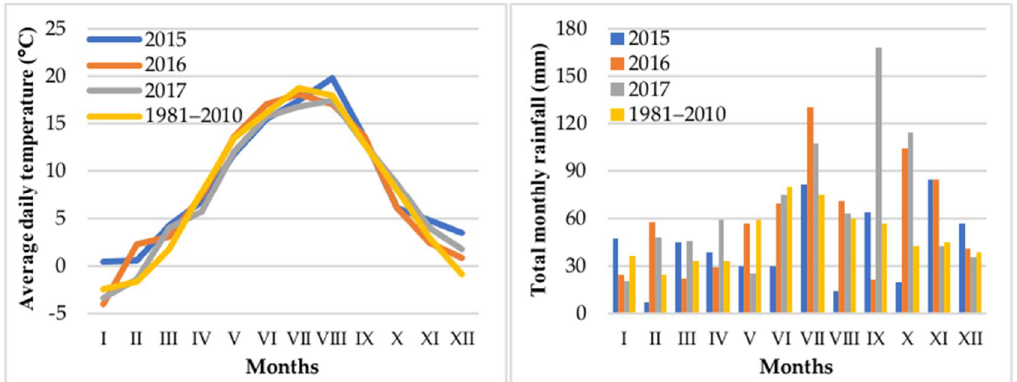
Figure 1. Weather conditions during the experiment (2015–2017) and the long-term average (1981– 2010) in the Agricultural Experiment Station in Tomaszkowo—data from an automated weather station (PM Ecology Ltd., Gdynia, Poland).